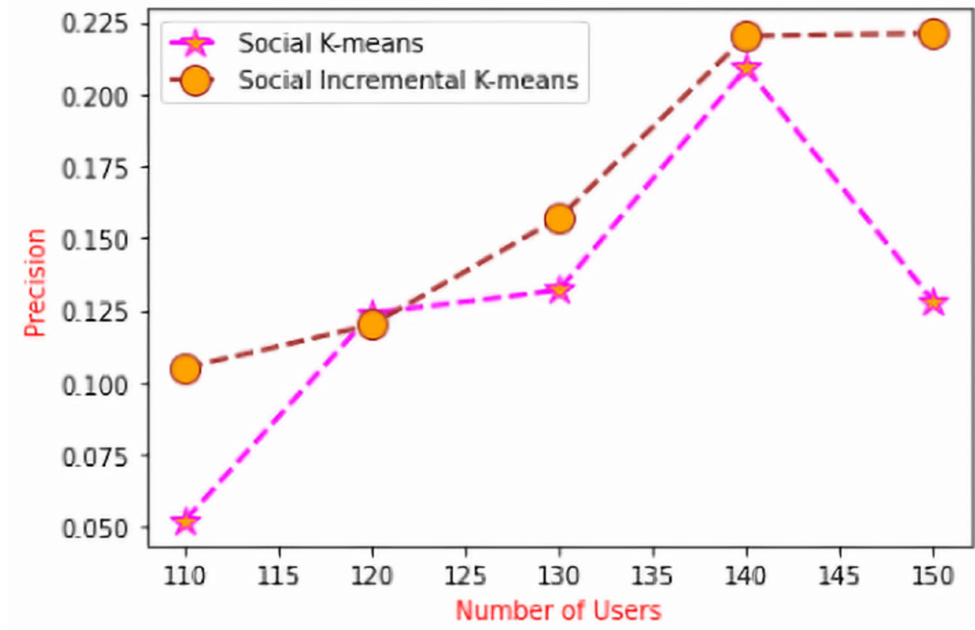
Figure 9. Precision—K-means versus incremental K-means algorithms with social